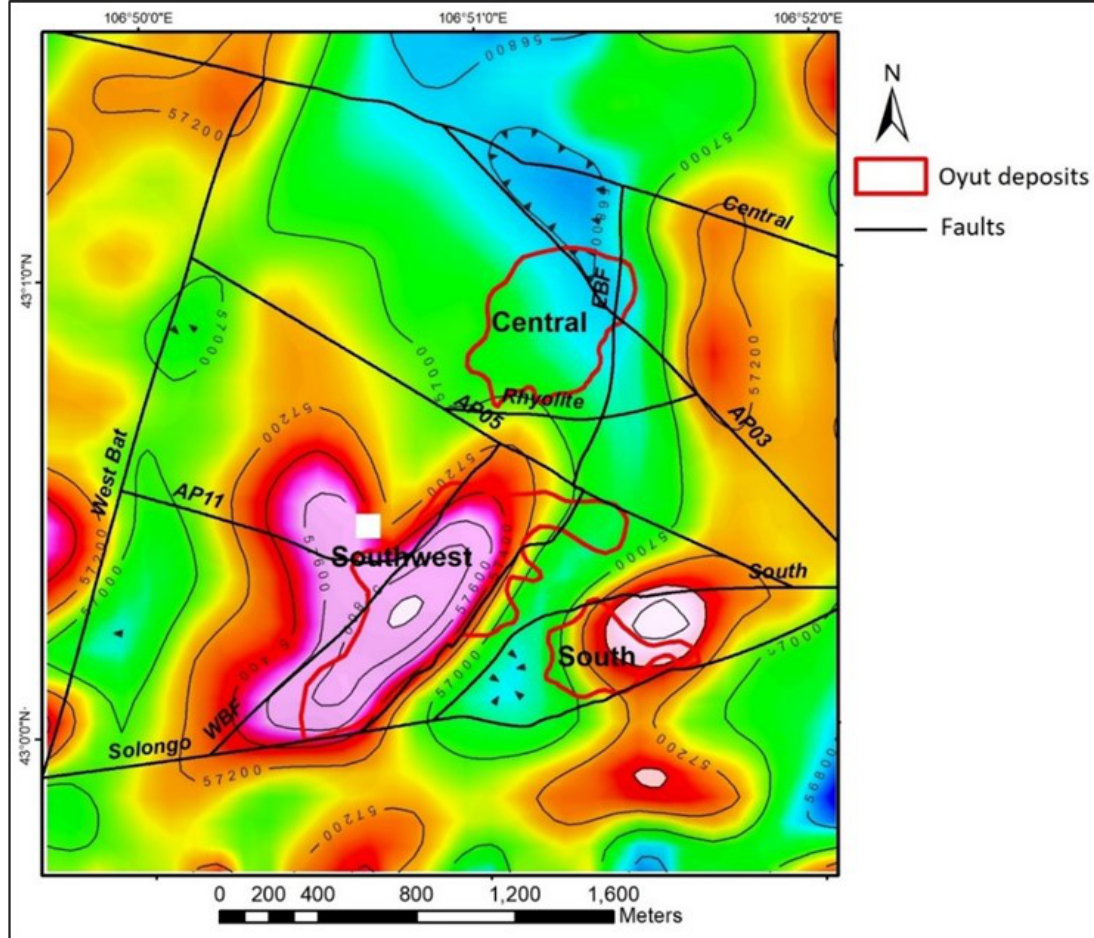
Fig. 3. Oyut deposits and faults on the ground magnetic Reduced To Pole map (legend in Fig. 6): WBF – West Bounding Fault, EBF – East Bounding Fault, AP- Assumed local